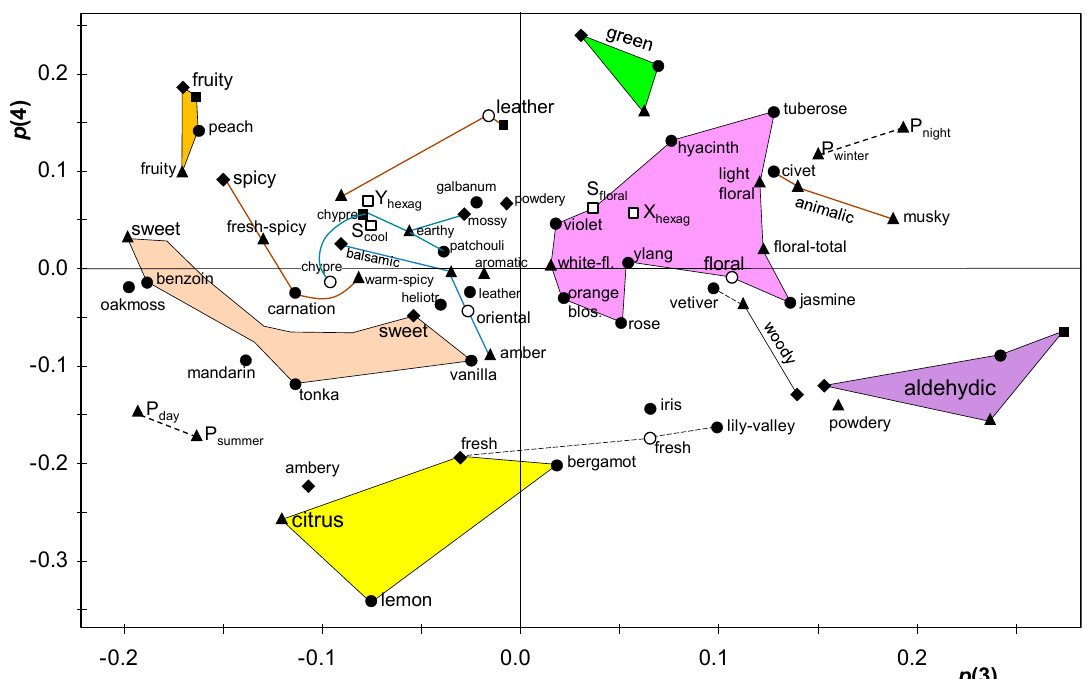
Figure 4. Loading plot ( p (4) versus p (3)) of the PCA applied to the olfactory profiles for the set of 140 perfumes. See Table 1 for list of variables included and point codes. Equivalent or related odor descriptors are joined with lines. Polygons are colored to highlight some odor classes.